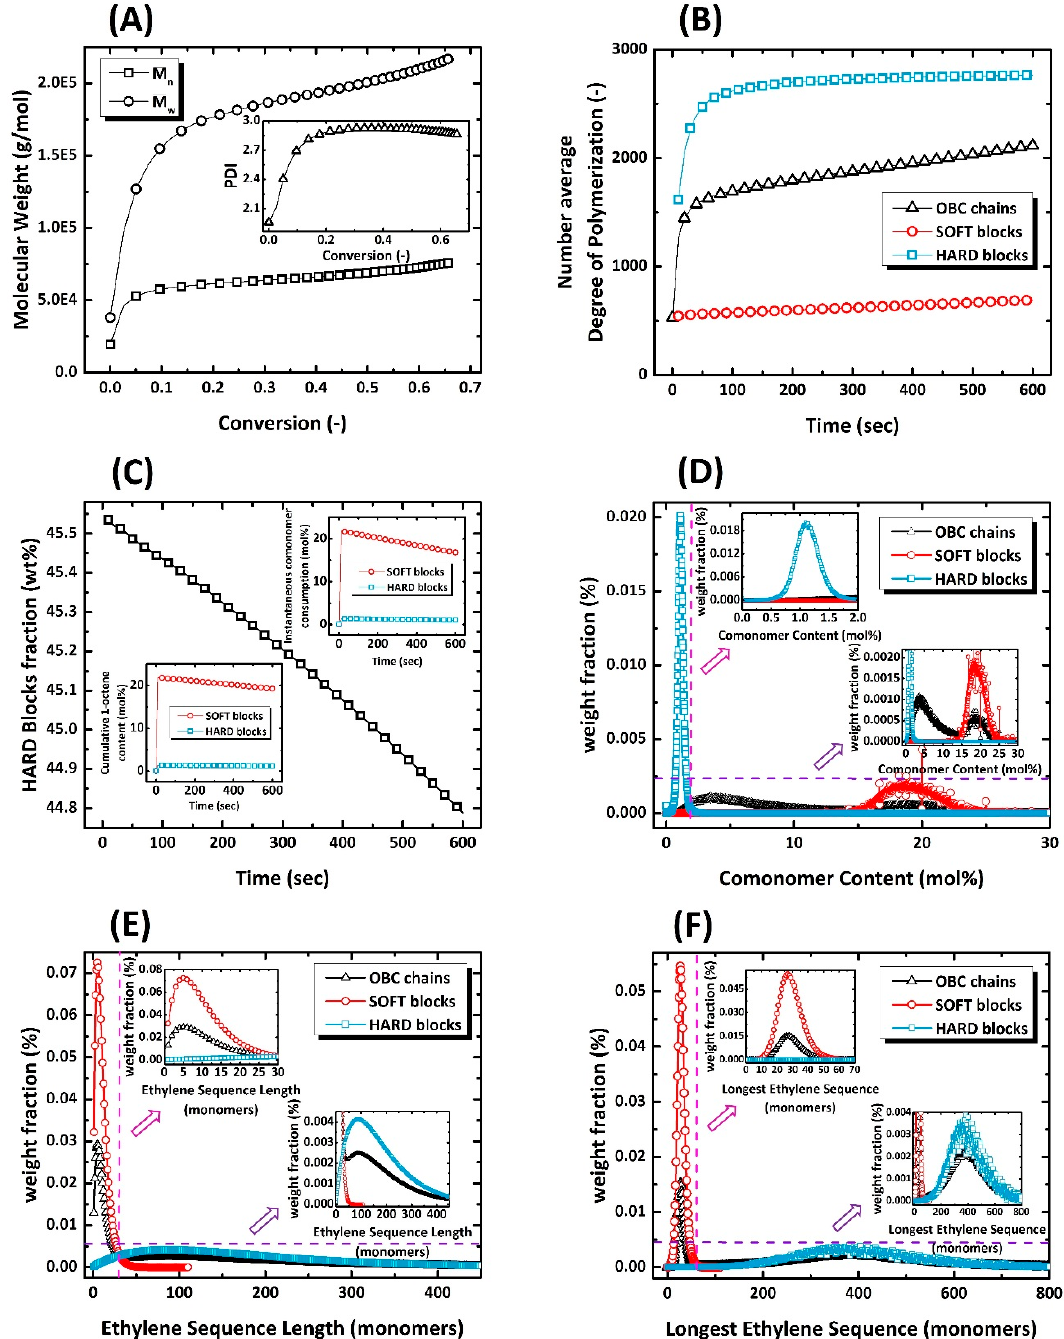
Figure 4. The identification card of intelligently synthesized OBC2 demonstrating all instantaneous and cumulative microstructural features of virtually produced chains.